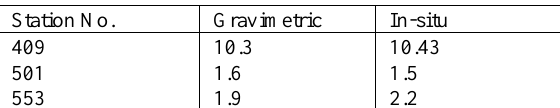
Table 2. Gravimetric vs. TDR-measured soil water content